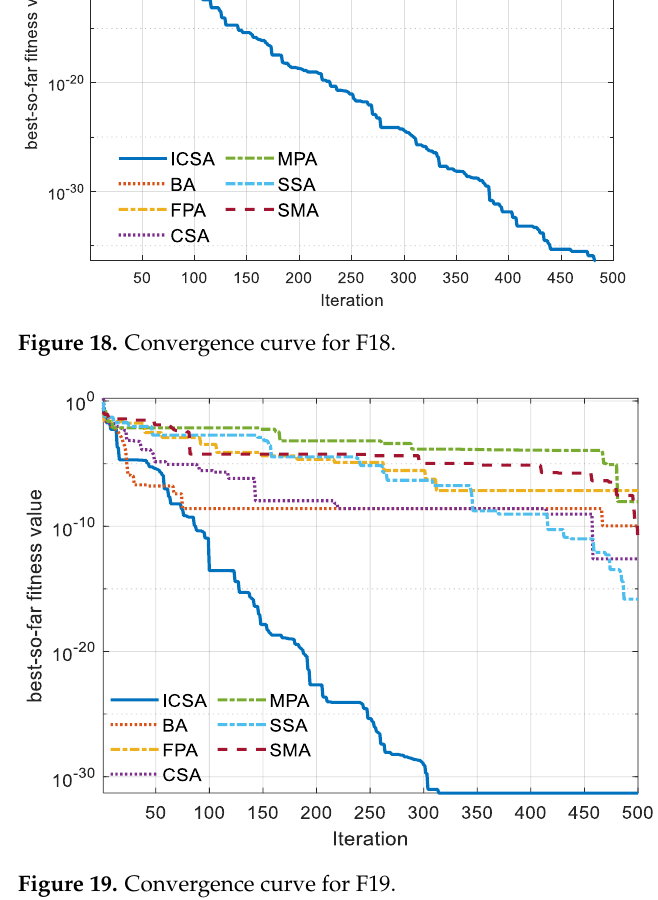
Figure 19. Convergence curve for F19.